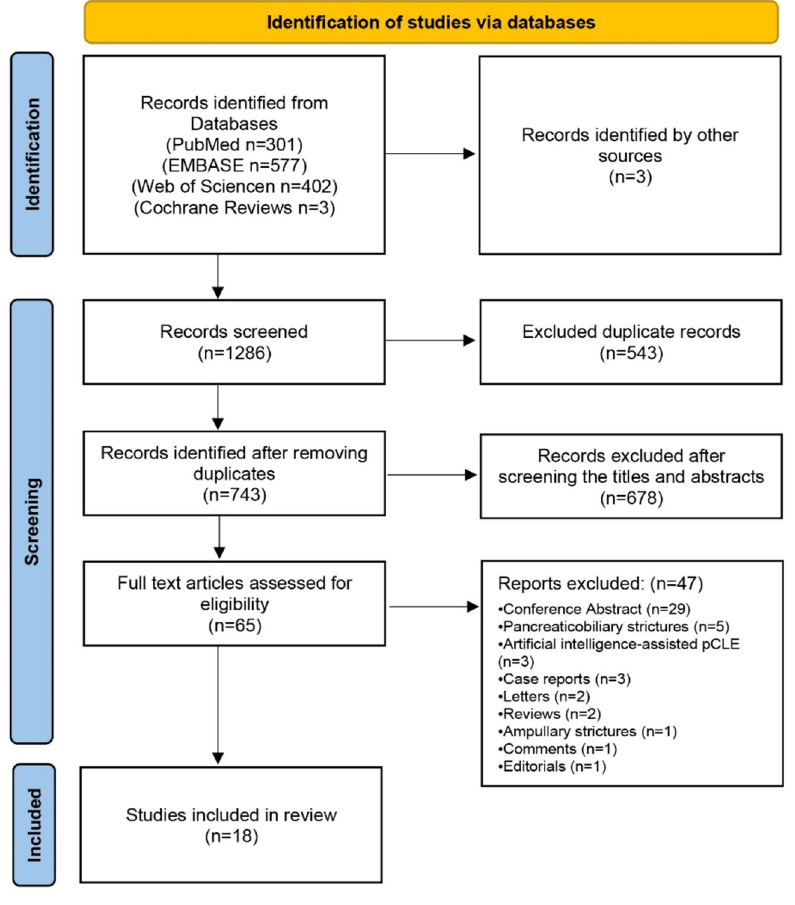
Figure 1. PRISMA flow